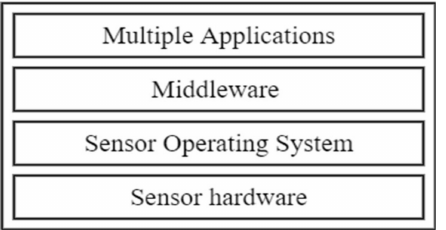
Figure 2. Middleware